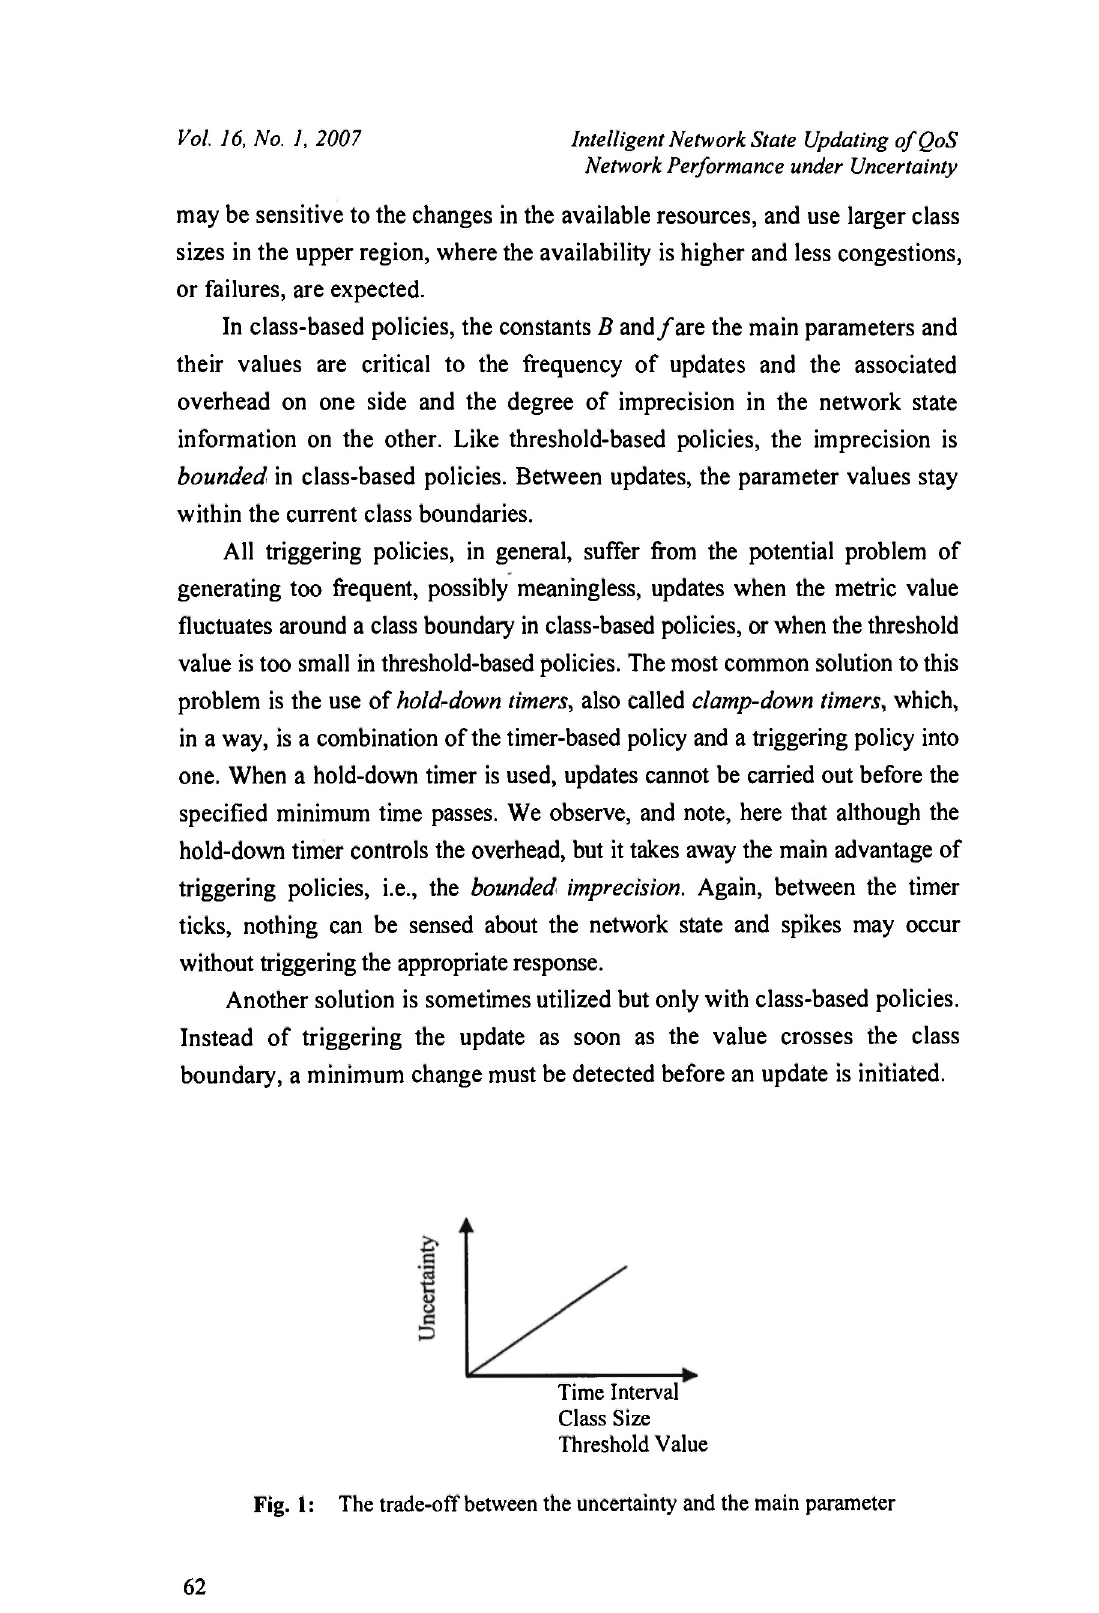
Fig. 1: The trade-off between the uncertainty and the main